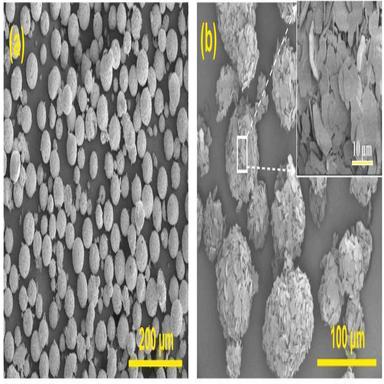
SEM images of feedstock powders: Yb2Si2O7 (a), hBN (b).